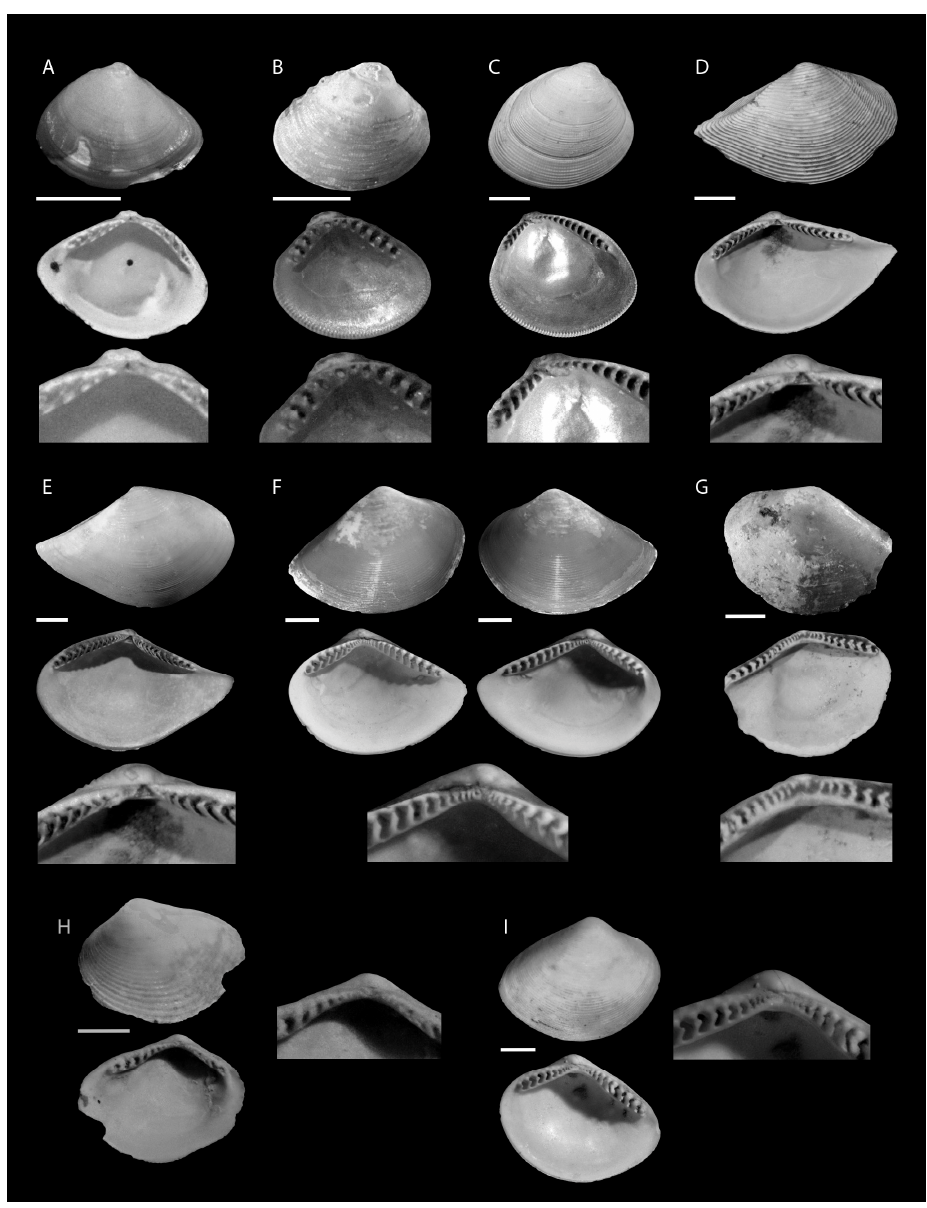
Figure 2. ( A ) Nucula callicrederma ; ( B ) Nucula culebrensis ; ( C ) Nucula proxima ; ( D ) Saccella acuta ; ( E , F ) Saccella concentrica ; ( G ) Katadesmia polita ; ( H ) Neilonella sp.; ( I ) Tindaria amabilis . Scale bars = 1